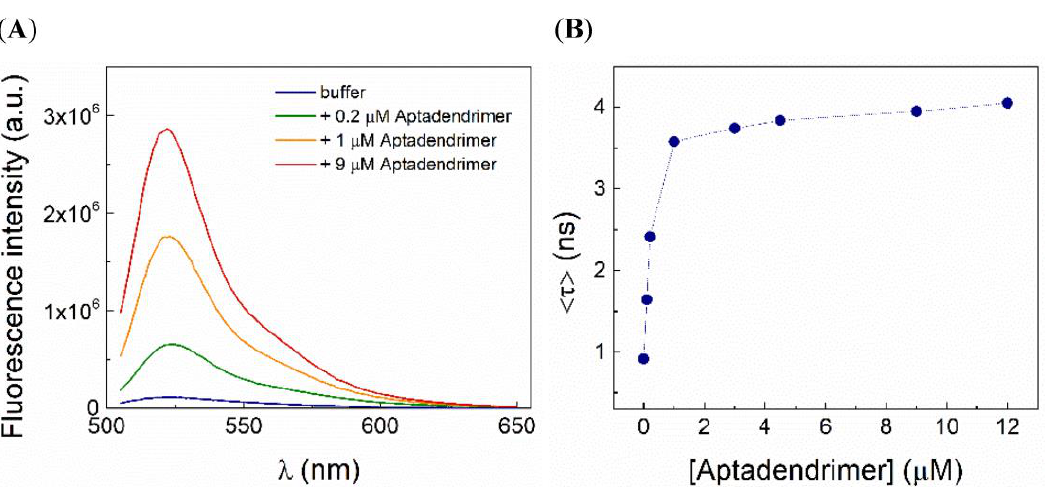
Figure 4. C 8 fluorescence is severely quenched in the buffer. Variations in ( A ) fluorescence emission spectra and ( B ) the amplitude-weighted mean fluorescence lifetime of 0.5 µM C 8 with increasing concentrations of aptadendrimer. concentrations of